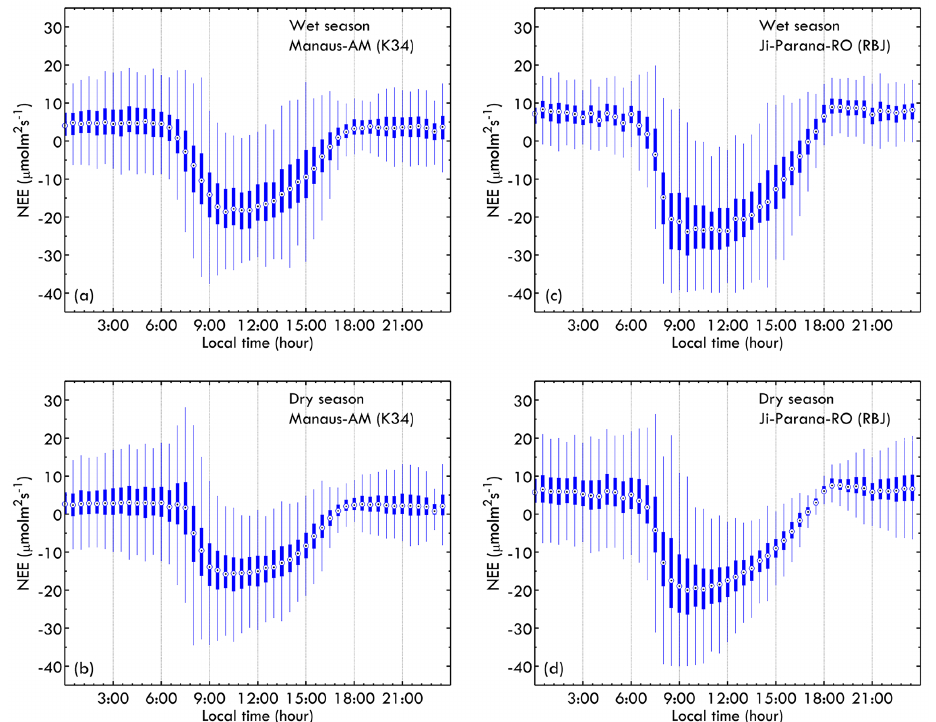
Figure 4. Seasonally averaged diurnal cycles of NEE for the wet and dry seasons in the tropical rainforests in Manaus/K34 (1999–2009), (a) and (b) , and in Ji-Parana/RBJ (1999–2002), (c) and (d)